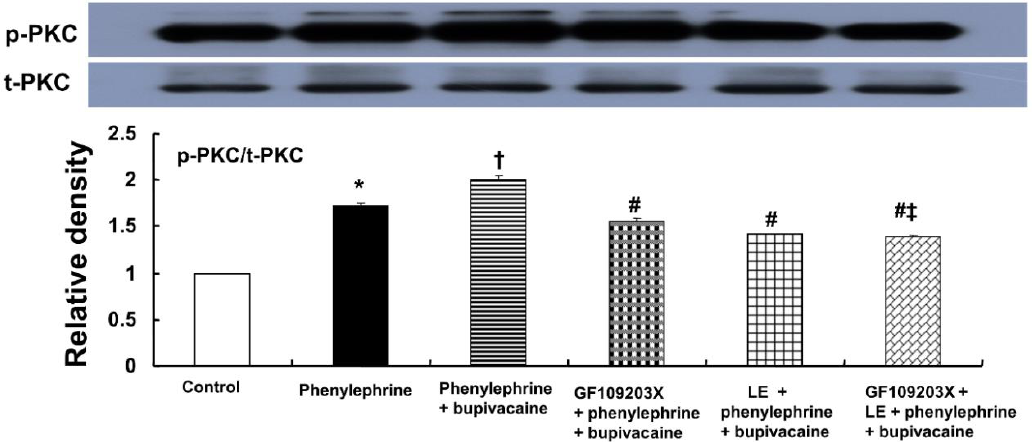
Figure 7. Effects of bupivacaine (10 −5 M), GF109203X (3 × 10 −6 M) and lipid emulsion (LE, 1%), alone or combined, on the protein kinase C (PKC) phosphorylation evoked by phenylephrine (10 −6 M) in rat aortic vascular smooth muscle cells (RAVSMCs). RAVSMCs were treated with phenylephrine (10 −6 M) alone for 10 min, pretreated with phenylephrine (10 −6 M) for 1 min followed by bupivacaine (10 −5 M) for 9 min, pretreated with 3 × 10 −6 M GF109203X for 70 min followed by 10 −6 M phenylephrine for 1 min and subsequently treated with 10 −5 M bupivacaine for 9 min, pretreated with LE (1%) for 40 min followed by phenylephrine (10 −6 M) treatment for 1 min and subsequently treated with 10 −5 M bupivacaine for 9 min, or pretreated with GF109203X for 30 min followed by LE (1%) for 40 min and subsequently treated with phenylephrine (10 −6 M) for 1 min and post-treated with bupivacaine (10 −5 M) for 9 min. PKC phosphorylation was examined by Western blot analysis as described in the Materials and Methods. Data ( n = 3) are expressed as the mean ± SD. Data were analyzed using one-way analysis of variance (ANOVA) followed by Bonferroni’s multiple comparison test. n indicates the number of independent experiments. p-PKC: phosphorylated PKC. t-PKC: total PKC. * p < 0.001 versus control. † p < 0.001 versus phenylephrine alone. # p < 0.001 versus phenylephrine + bupivacaine. ‡ p < 0.001 versus GF109203X + phenylephrine + bupivacaine.